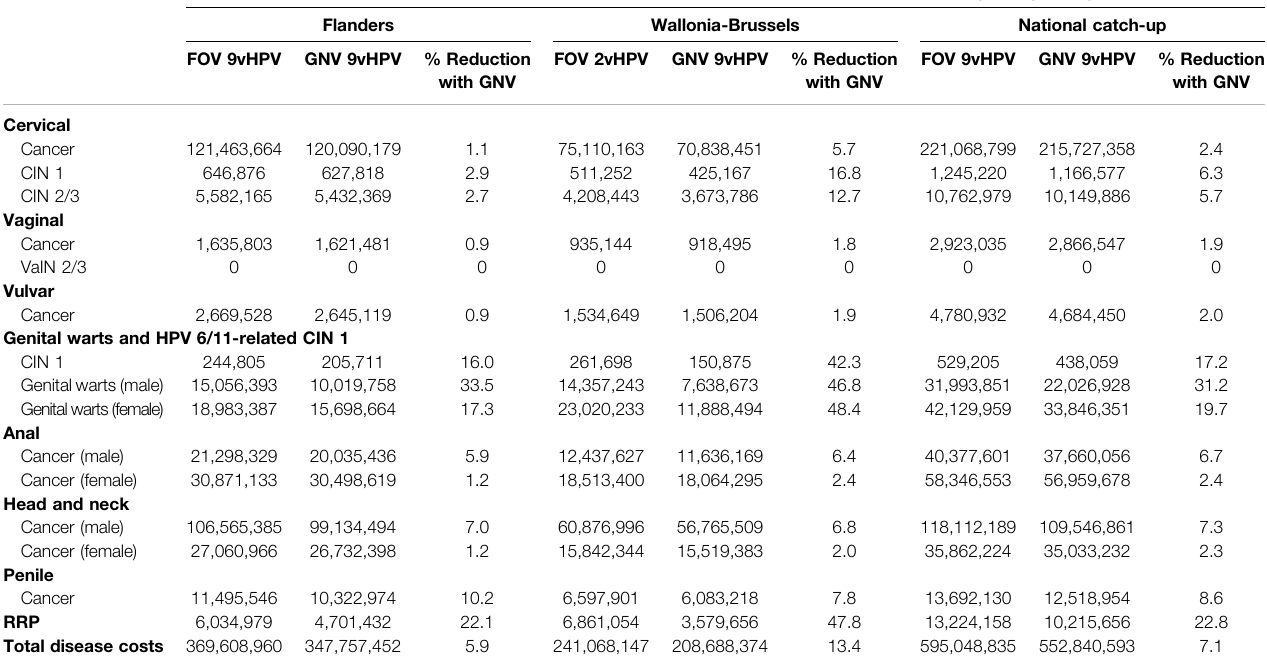
TABLE 7 | Estimated reductions in cumulative HPV-related disease costs over 100 years with 9vHPV vaccination in females and males compared with female-only